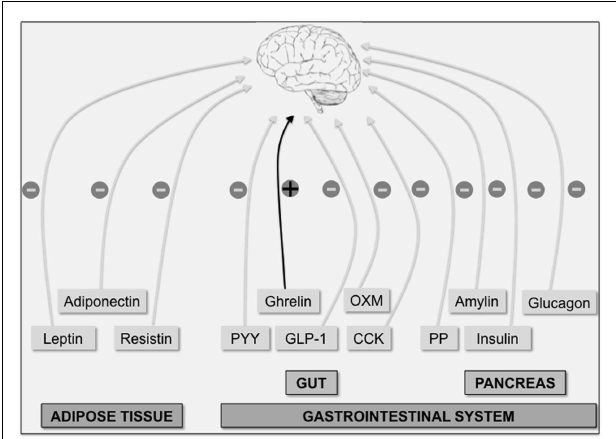
FIGURE 1 |The brain integrates multiple peripheral signals to control appetite . Peripheral factors indicative of long-term energy whole-body status are produced by adipose tissue (leptin, adiponectin, and resistin). On the other hand, acute orexigenic ( + ) ghrelin signal (produced in the gut) and anorexigenic ( − ) signals such as the gut hormones peptideYY (PYY), oxyntomodulin (OXM), glucagon-like peptide-1 (GLP-1) and cholecystokinin (CCK), and the pancreatic hormones [insulin, glucagon, amylin, and pancreatic polypeptide (PP)] indicate long-term energy